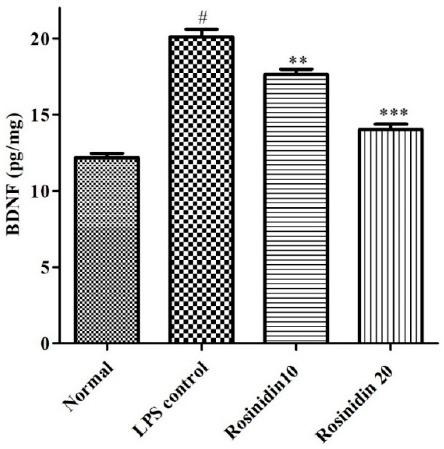
Figure 11. Effect of rosinidin on BDNF levels in LPS-treated rats. Values are expressed in mean ± S.E.M. (n = 6). # p < 0.05 vs. normal control rats and ** p < 0.01 and *** p < 0.001 vs. LPS control rats. One-way ANOVA followed by Tukey’s post hoc test.